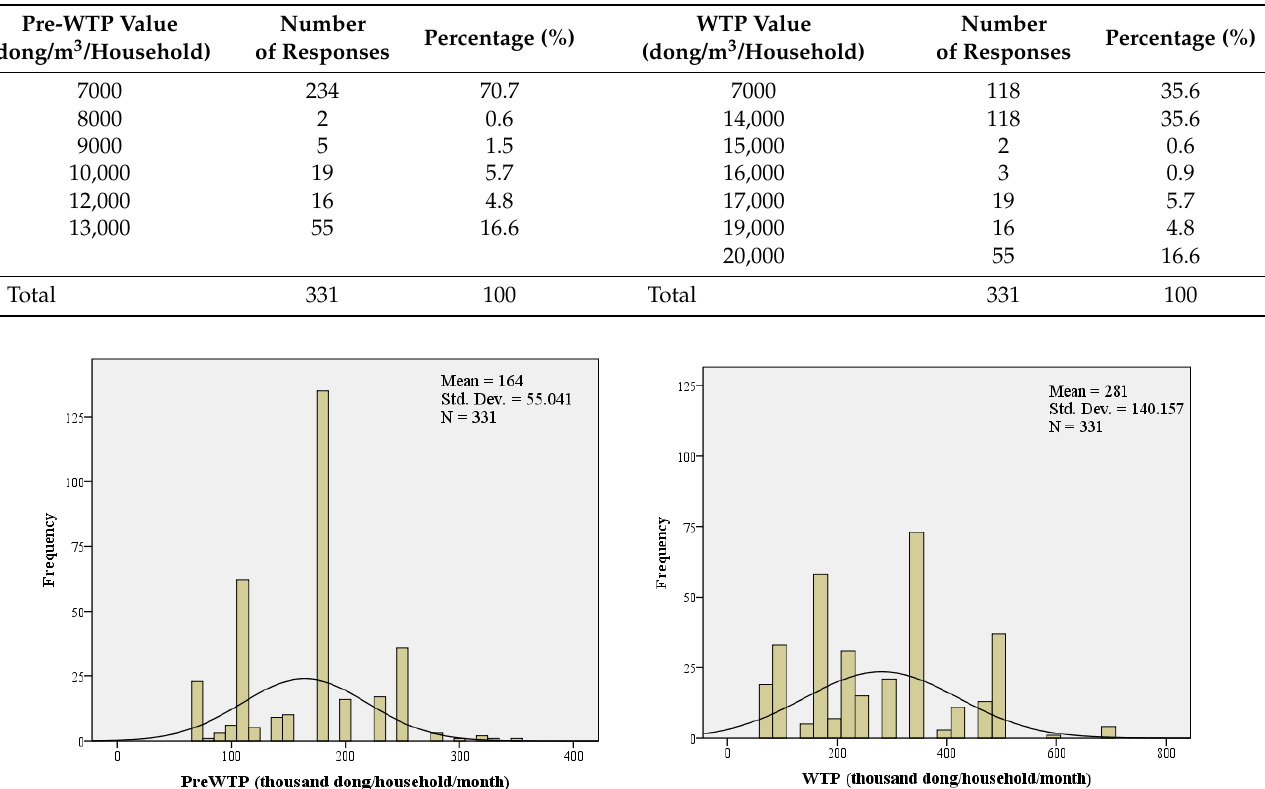
Figure 4. Pre-WTP and WTP